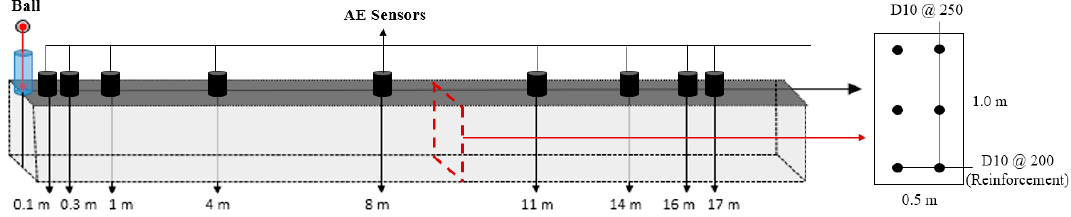
Figure 3. Schematic diagram of experiments.